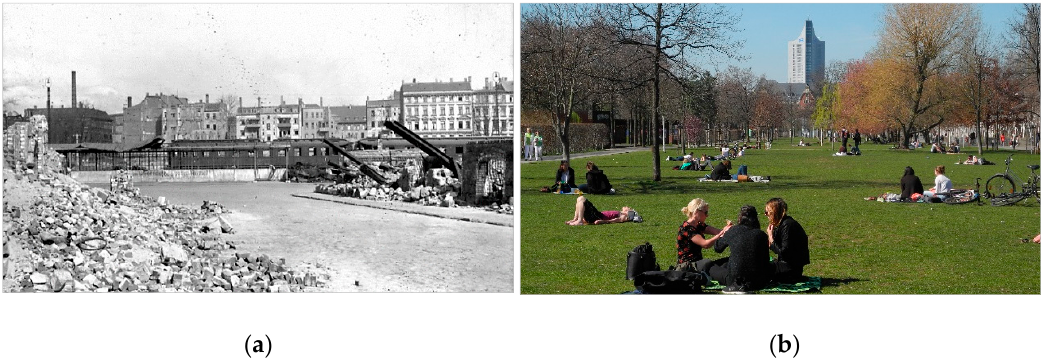
Figure 2. ( a ) The railway industrial area in Reudnitz [72] has been transformed into ( b ) the Lene-Voigt-Park (LVP) (Photo: Annegret